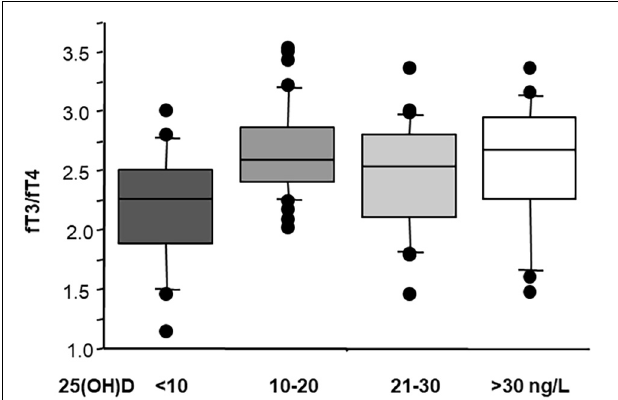
FIGURE 3 | Values of fT3/fT4 according to 25(OH)D status in 124 AMI patients (ANOVA; severe hypovitaminosis D versus normal vitamin D p ≤ 0.001). Median, interquartile, outliers, and extremes of fT3/fT4 are